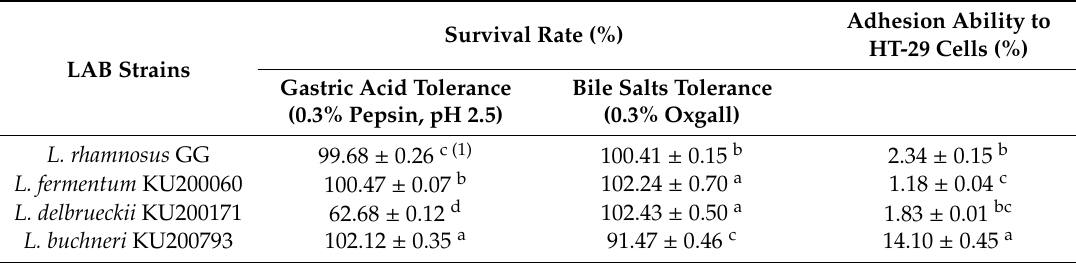
Table 1. Tolerance of Lactobacillus strains to artificial gastric conditions and its adhesion ability to the HT-29